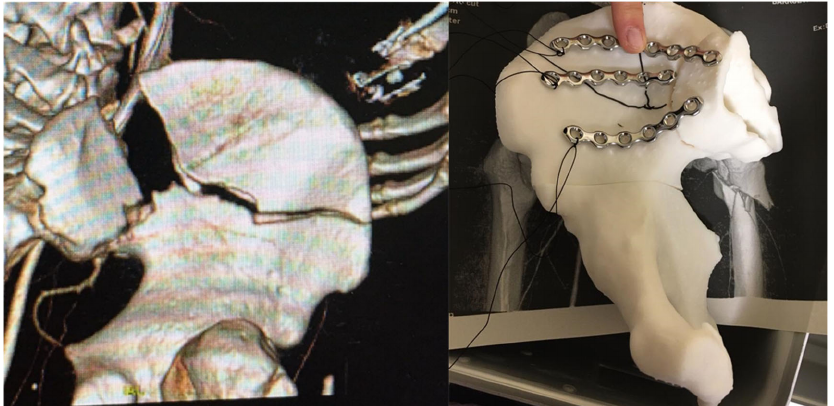
Figure 5. Anatomical model for pre ‐ modeling synthesis plates for surgical treatment of acetabular fractures (traumatological surgery). Left : CT image, volumetric render of bone fracture. Right : Anatomical model for preformed osteosynthesis plates manufactured by SLA technology.